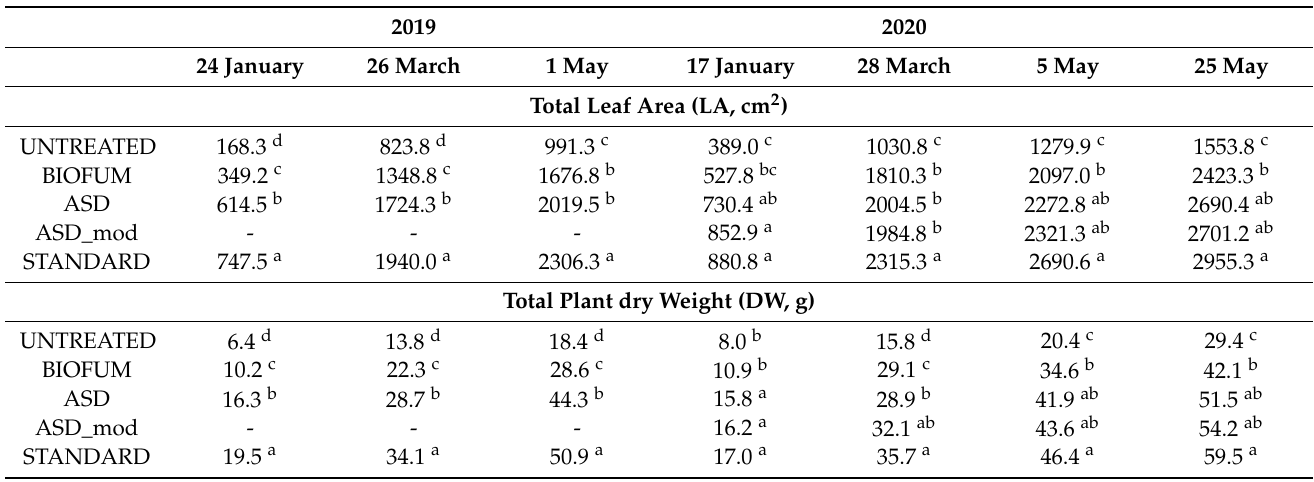
Table 1. Total leaf area (LA, cm 2 ∙plant −1 ) and dry weight (DW, g plant −1 ) of cv. Sabrosa* plants developed under different soil pre-planting treatments in the 2018/2019 and 2019/2020 seasons in Scanzano Jonico, south of Italy.